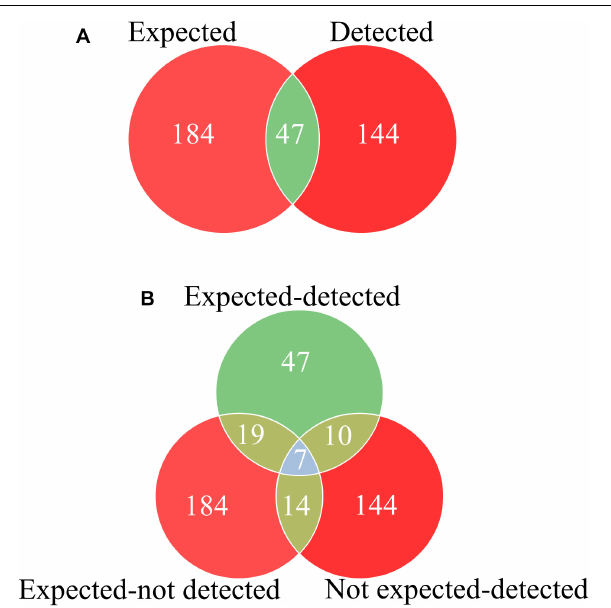
FIGURE 1 | Discrepancies between listed species and detected species using DNA metabarcoding in Ayurvedic herbal products. (A) Total number of occurrences of expected species as labeled in the herbal products and detected species using DNA metabarcoding. (B) Total number of detected species occurred among expected species as labeled in herbal products (expected-detected), the number of undetected species among the expected species as labeled (expected-not detected), and the number of detected unexpected species (not expected-detected) found in herbal products using DNA metabarcoding. The overlapping numbers are the same species detected in herbal products as expected, detected and unexpected detected.